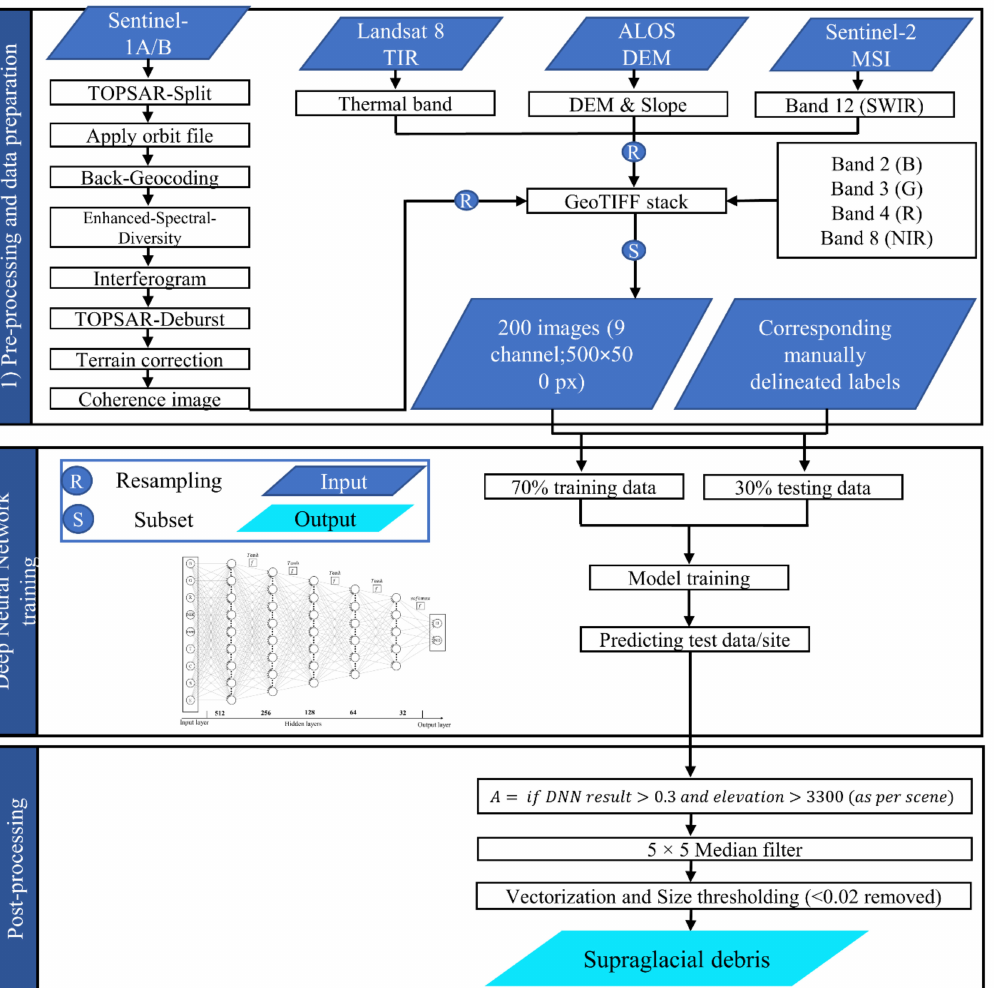
Figure 3. Workflow for automated supraglacial debris mapping using remote sensing and deep